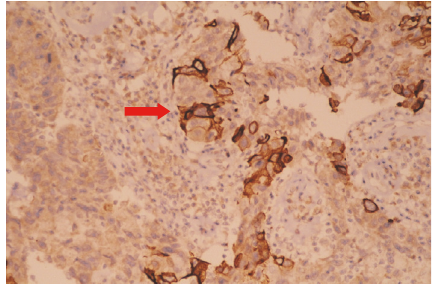
Figure 1: Contrast enhanced computed tomography (CE-CT) image showing cystic right ovary with arrow pointing to enhanced solid densities within the cyst.